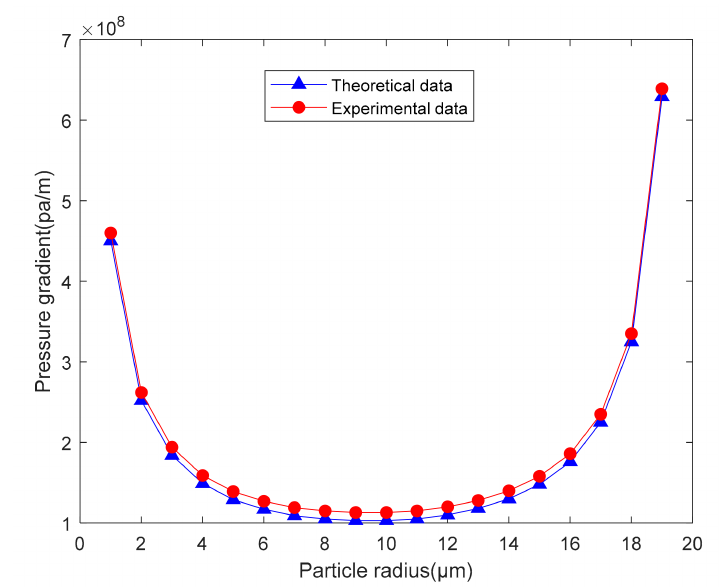
Figure 10. The difference between theoretical data and experimental data.